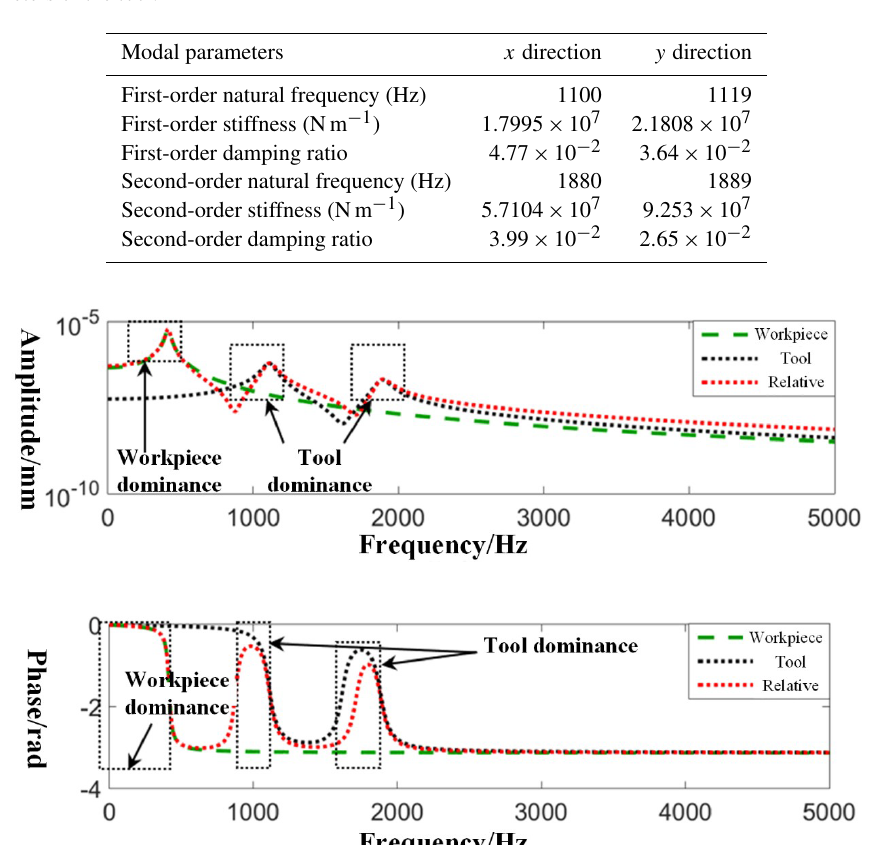
Figure 5. Comparison of the amplitude–frequency characteristics of the three functions.